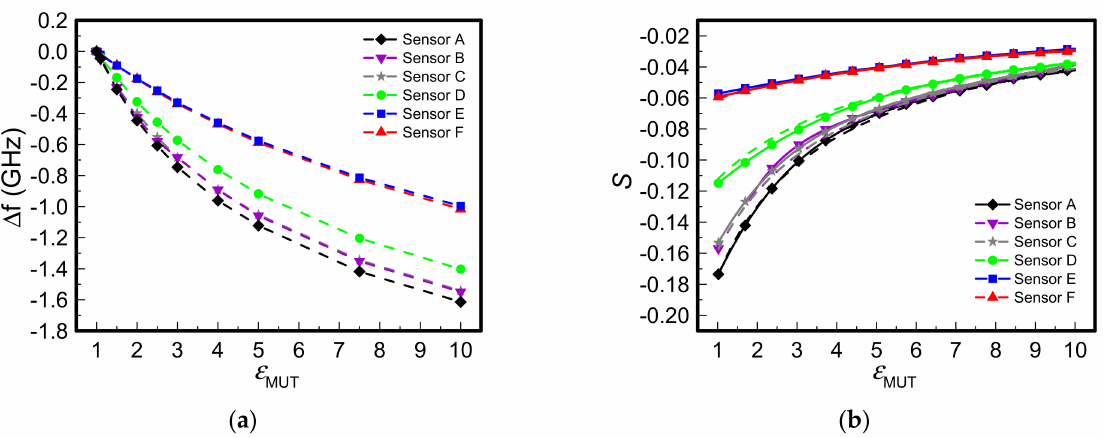
Figure 5. Variation of the resonance frequency with the dielectric constant of the MUT ( a ) and relative sensitivity ( b ) for sensors A, B, C, D, E and F. The theoretical relative sensitivities inferred from Equation (9) are also included in the figure (dashed